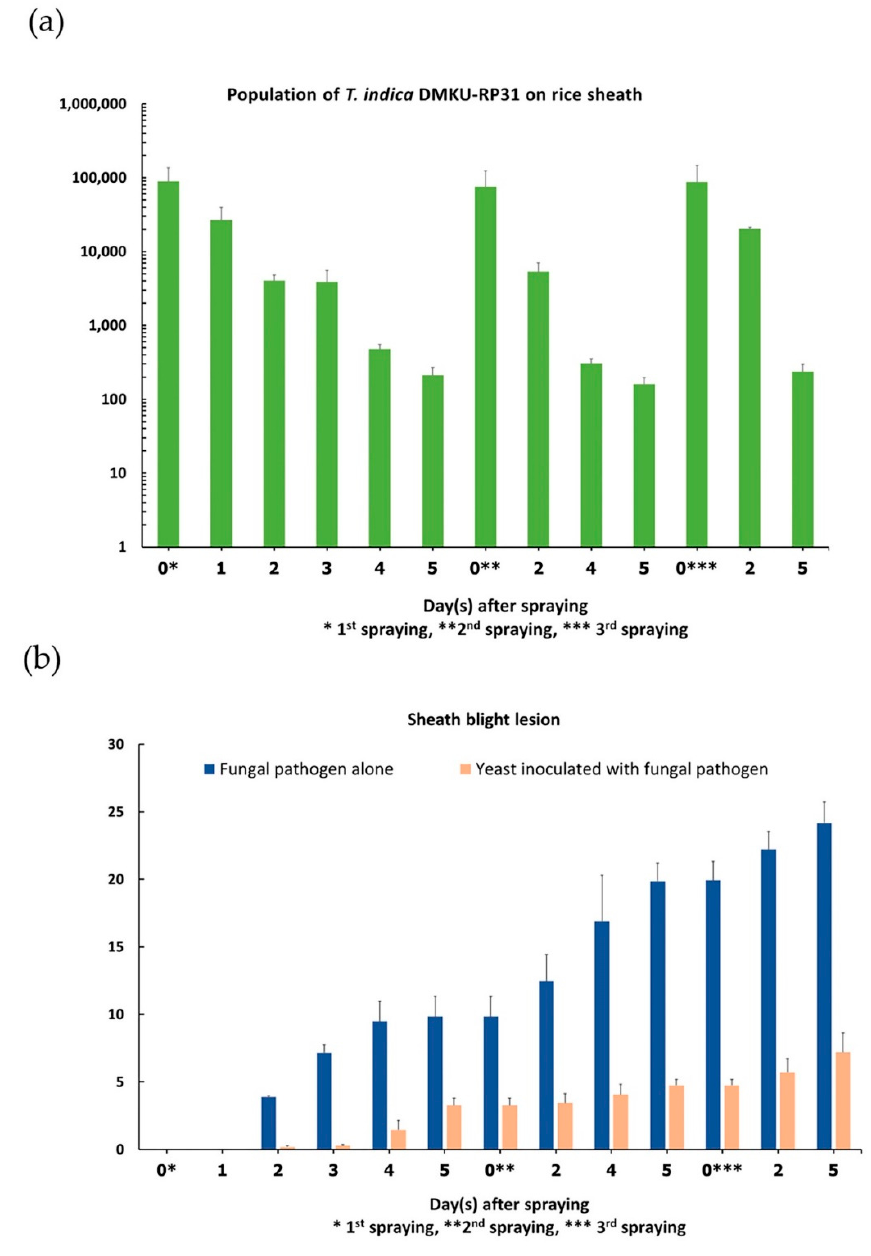
Figure 2. Yeast population and sheath blight diseases development. ( a ) Population of T. indica DMKU-RP31, ( b ) rice sheath blight lesion height.